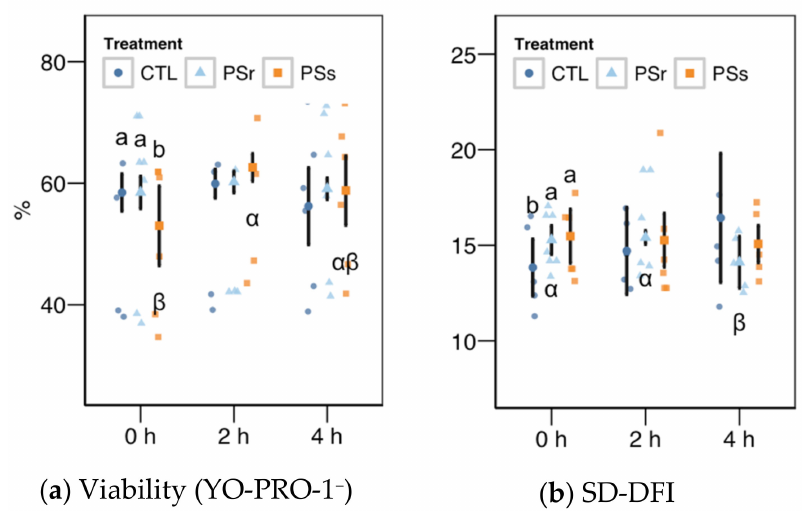
Figure 4. Results for the viability as YO-PRO-1 + events ( a ) and the SD-DFI (standar deviation of the DNA fragmentation index) parameter for SCSA (Sperm Chromatin Structure Assay) ( b ) as these variables showed a significant interaction between the treatment and the incubation (mean ± CI95% with individual observations as dots, n = 6) during the incubation (4 h at 37 ◦ C) of thawed boar spermatozoa with seminal plasma from boars whose spermatozoa were resistant or sensitive to the cold-shock (PSr and PSs) or incubated with just MR-A (control, CTL). Different Latin letters show significant differences among treatments within each incubation time ( p < 0.05), and different Greek letters show significant differences among incubation times within each treatment ( p <